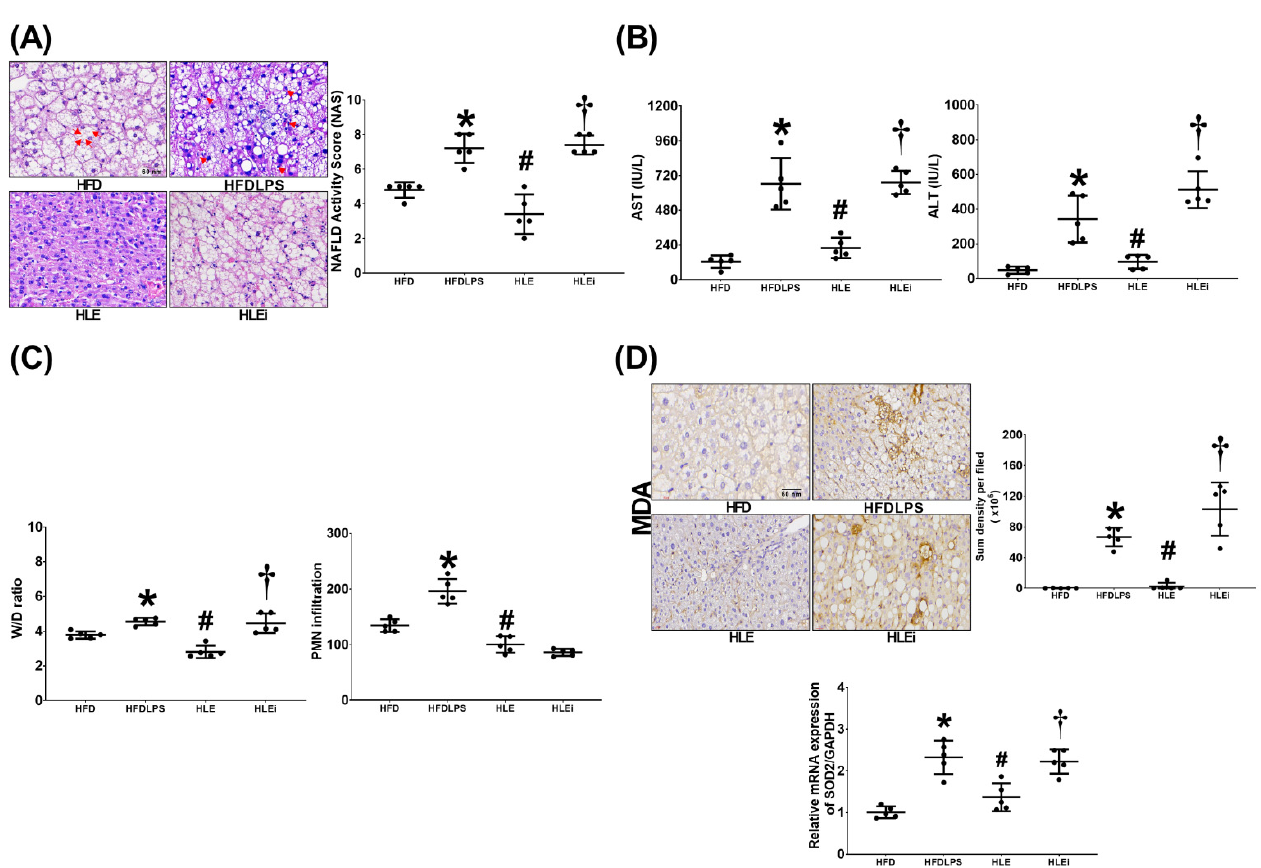
Figure 3. ( A ) Representative microscopic findings of the liver tissues stained with hematoxylin-eosin (200 × ) and the organ injury scores (NAFLD activity scores). Data were obtained from 5 mice in each group. ( B ) Plasma concentrations of hepatic enzymes aspartate aminotransferase (AST) and alanine aminotransferase (ALT). Data were obtained from 5 mice in each group ( C ). Wet/dry weight ratio (W/D ratio, an indicator of tissue water content) and polymorphonuclear leukocyte (PMN) infiltration levels in liver tissues. Data were obtained from 5 mice in each group ( D ). Representative microscopic images of malondialdehyde (MDA, an indicator of oxidation, using an immunohisto- chemistry staining assay) and the quantitative sum intensities of MDA in liver tissues. The relative mRNA expression of superoxide dismutase 2 (SOD2) in liver tissues (using a quantitative real-time polymerase chain reaction assay and normalized to the internal standard glyceraldehyde 3-phosphate dehydrogenase [GAPDH]). Data were obtained from 5 mice in each group. All assays were performed 48 h after endotoxin or normal saline (NS) administration in the surviving mice. Data were presented as means ± standard deviations. HFD: the high-fat diet plus intraperitoneal (ip) administration of NS (0.5 mL) group. HFDLPS: the high-fat diet plus endotoxin (10 mg/kg, ip) group. HLE: the high-fat diet plus endotoxin plus exosomes (from human placenta choriodecidual membrane-derived mes- enchymal stem cells, pcMSCs, 1 × 10 8 particles per mouse, ip) group. HLEi: the high-fat diet plus endotoxin plus microRNA-inhibitor-pretreated exosomes (1 × 10 8 particles per mouse, ip) group. NAFLD: non-alcoholic fatty liver disease. * p < 0.05, versus the HFD group; # p < 0.05, the HLE group versus the HFDLPS group. † p < 0.05, the HLEi group versus the HLE